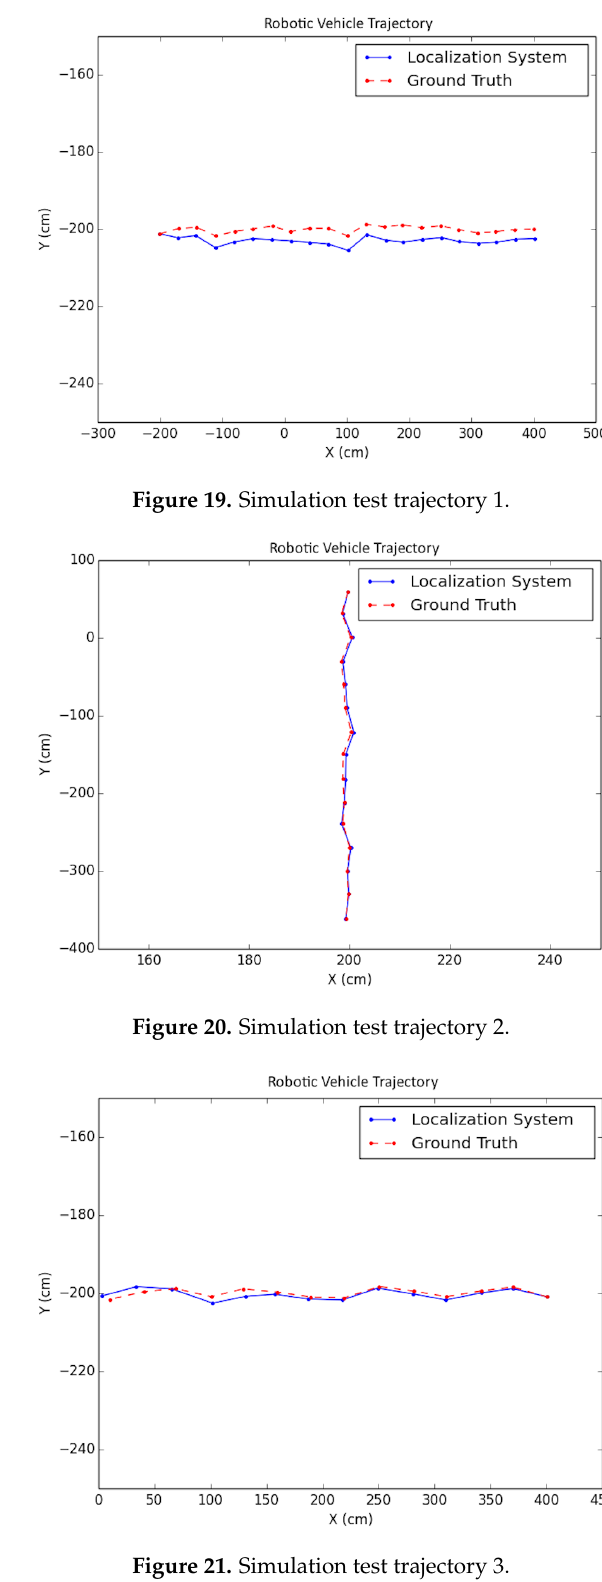
Figure 21. Simulation test trajectory